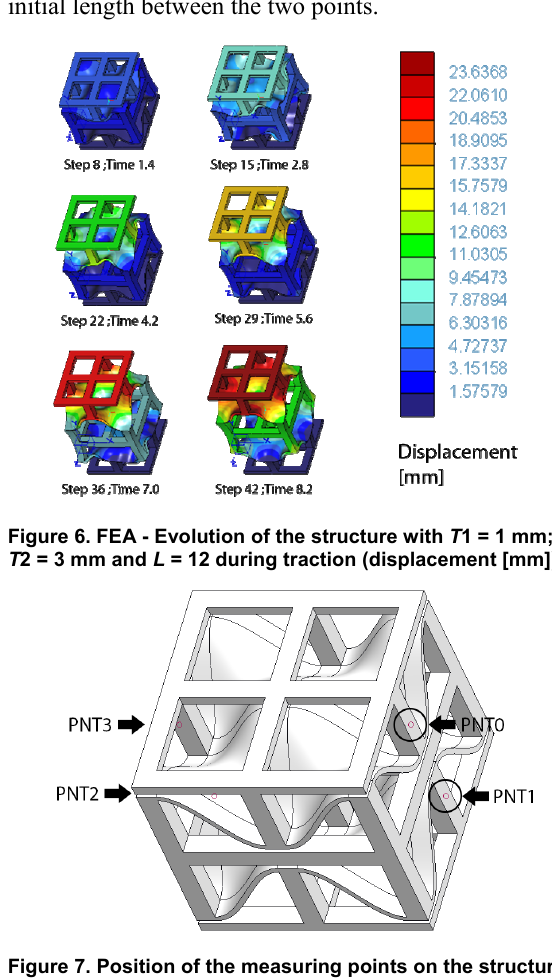
Figure 7. Position of the measuring points on the structure